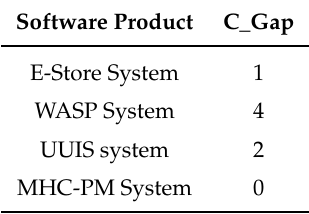
Figure 5. Number of identified clusters against number of FRs for each software product. Table 5. C_Gap Values of the identified clusters for each software